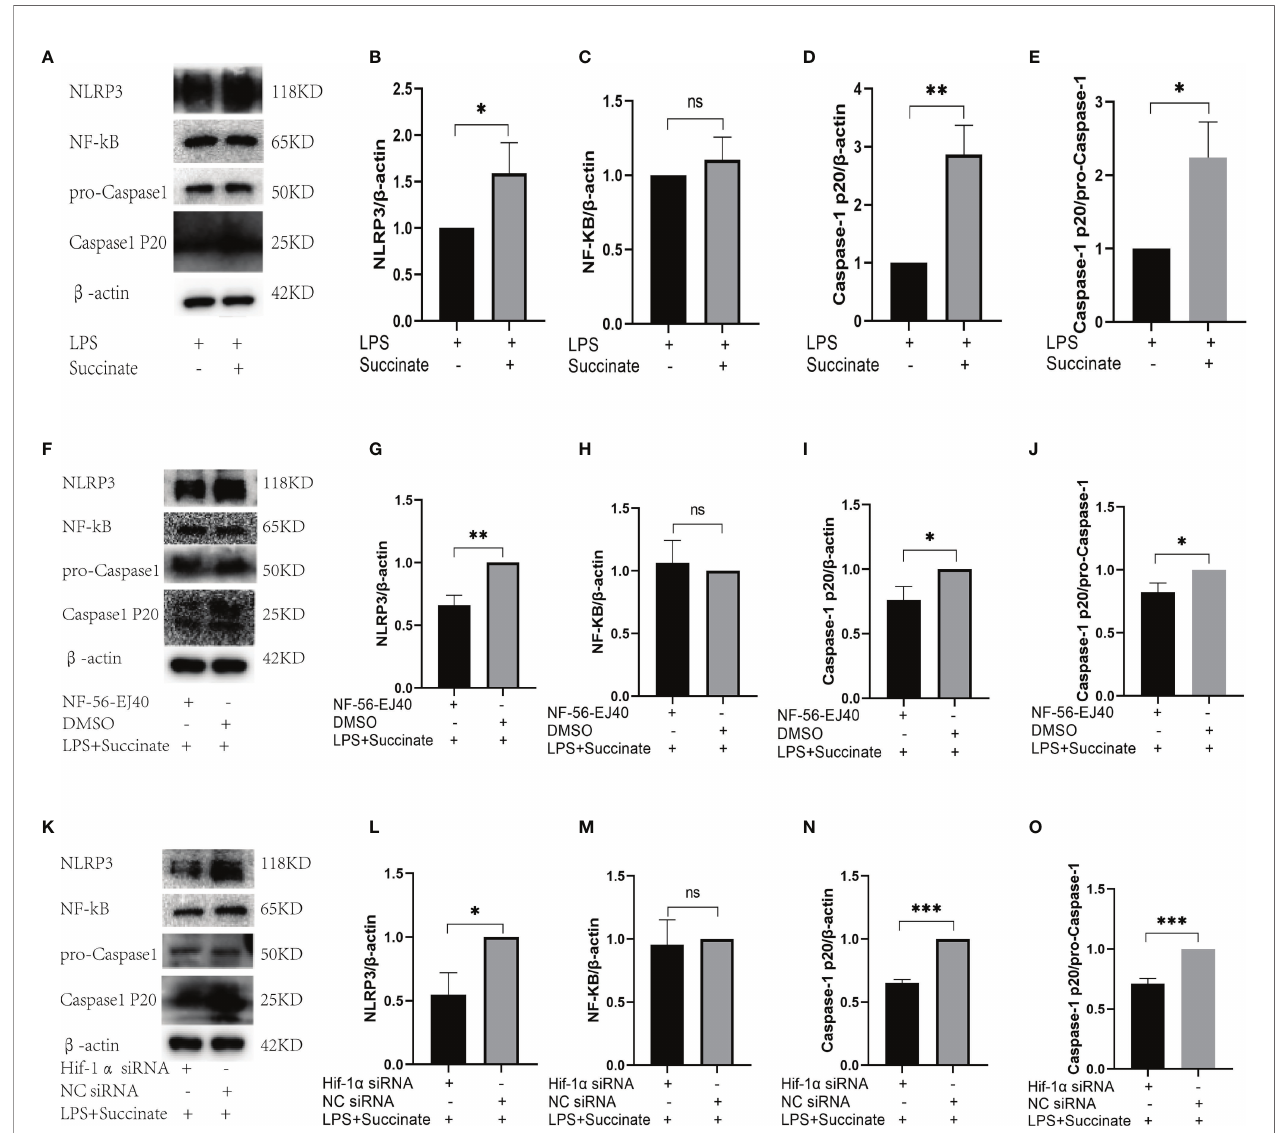
FIGURE 6 | The relation between NF- k B pathway and succinate/IL-1 b signal axis. (A – E) The expression levels of NF- k B, NLRP3, and Caspase-1 in HUVECs after succinate stimulation. (F – J) The expression levels of NF- k B, NLRP3, and Caspase-1 in HUVECs after NF-56-EJ40 inhibition. (K – O) The expression levels of NF- k B, NLRP3, and Caspase-1 in HUVECs after Hif-1 a knockout. Western blot data present mean ± SEM from three independent experiments at least. * P < 0.05; ** P < 0.01; *** P < 0.001; ns means no statistical